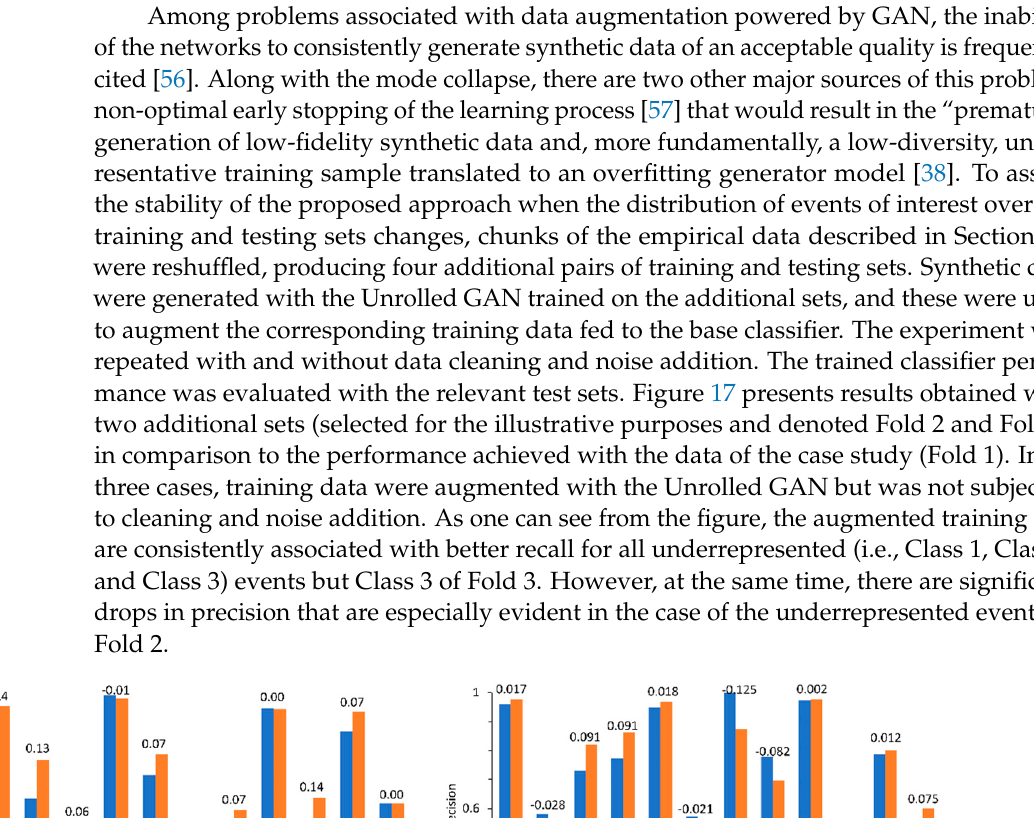
Figure 16. Classification performance of the base classifier trained on: ( a ) unbalanced data, ( b ) noise addition augmented data, ( c ) time-stretching + noise addition augmented data, ( d ) undersampling + noise addition, and ( e ) the augmented data of the case study.